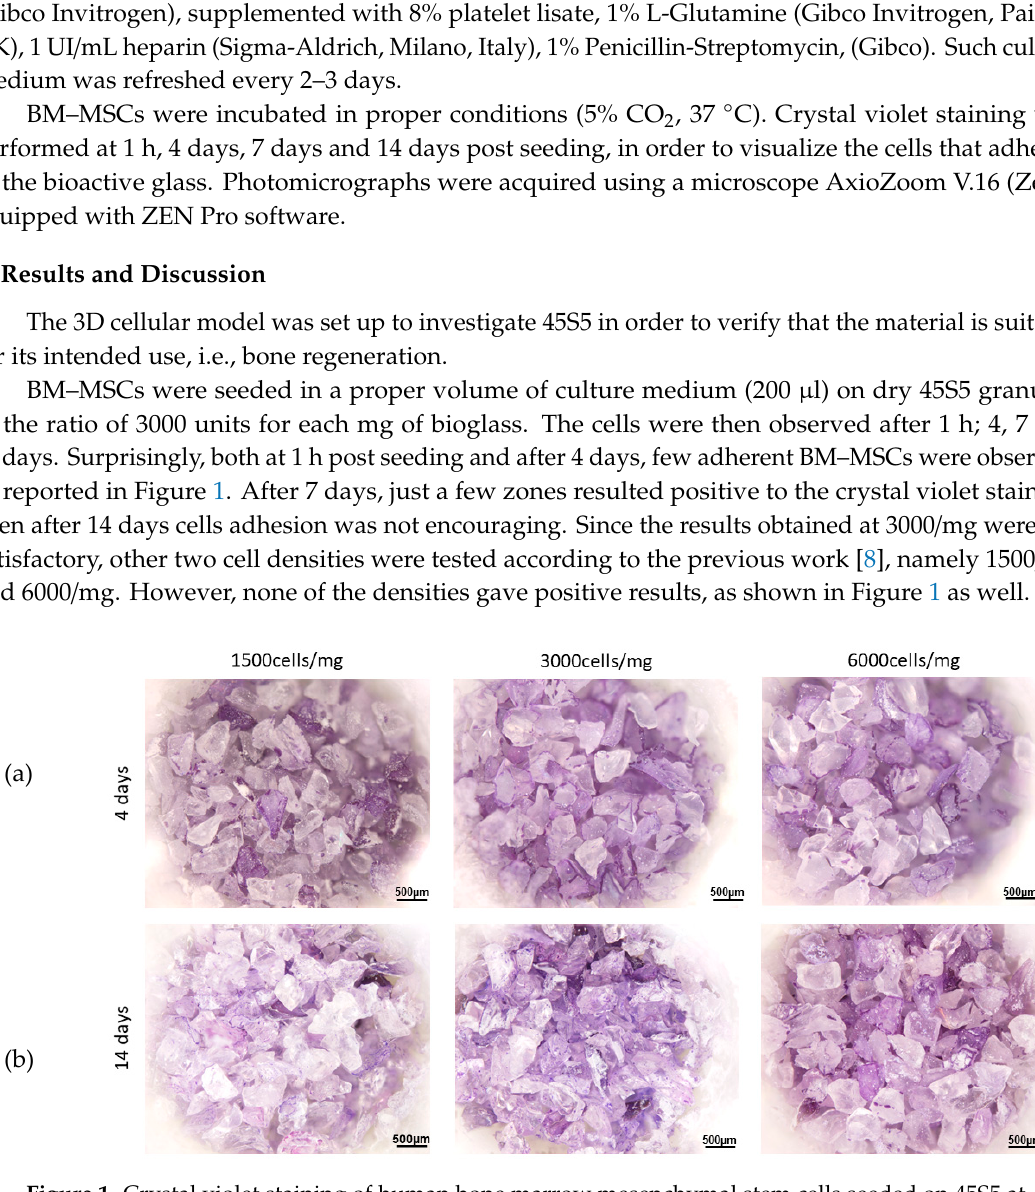
Figure 1. Crystal violet staining of human bone marrow mesenchymal stem cells seeded on 45S5 at 4 days ( a ) and 14 days ( b ) after seeding, with 3 different cells densities (1500/mg, 3000/mg and 6000/mg).